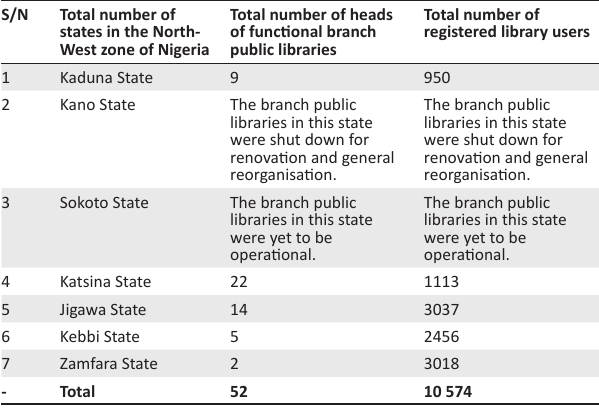
TABLE 1: Population of the study. S/N Total number of states in the North- West zone of